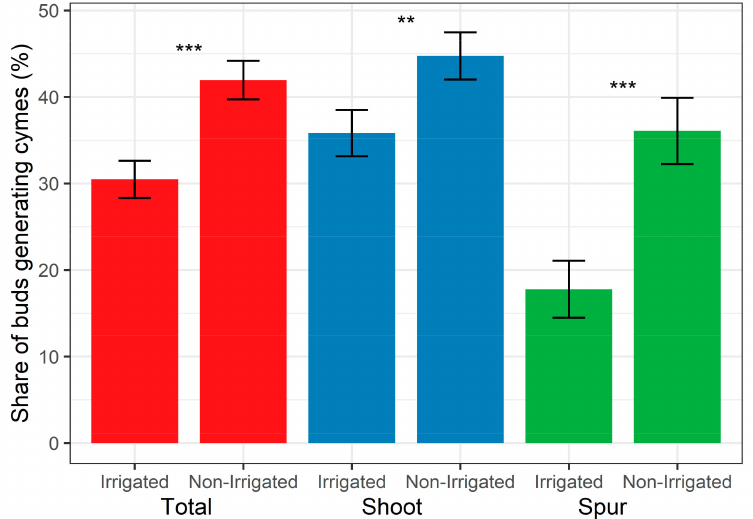
Figure 8. Share of apical flower buds generating cymes for apple trees cv. ‘Elstar’ exposed to two irrigation regimes. Measurements were taken on the 22nd of April 2019 in Campus Klein-Altendorf. Bar colors indicate the structure on which the bud developed (one-year-old shoots versus spurs), with red bars illustrating results for all sampled buds. Error bars in each category show the standard error of the mean. In total, 602 buds were counted, out of which 212 (35%) were from spurs and 390 (65%) were from one-year-old shoots. *** represents p < 0.001 and ** means p <